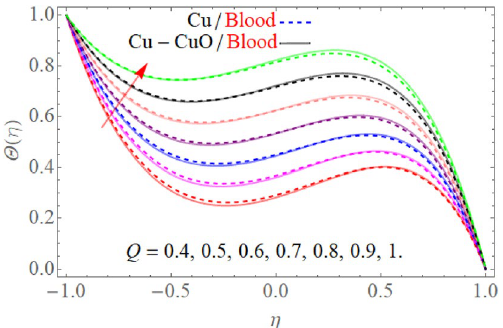
Figure 7. Q > 0 influence on θ(η) .